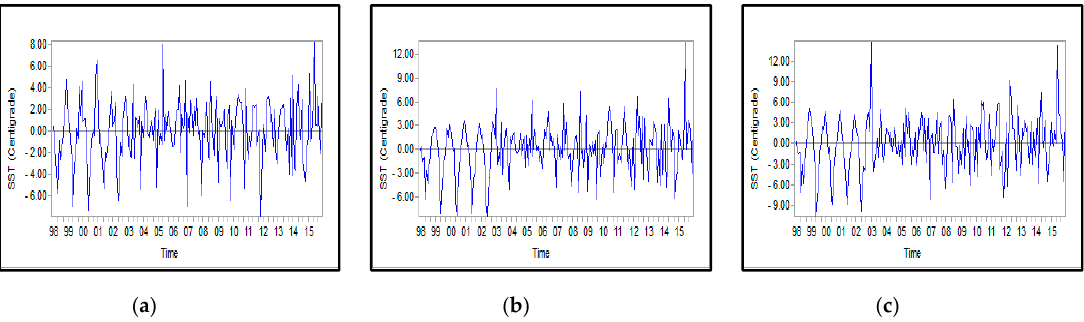
Figure A8. Monthly anomalies of the surface temperature for: ( a ) Northern, ( b ) Middle, and ( c ) Southern Caspian Sea.